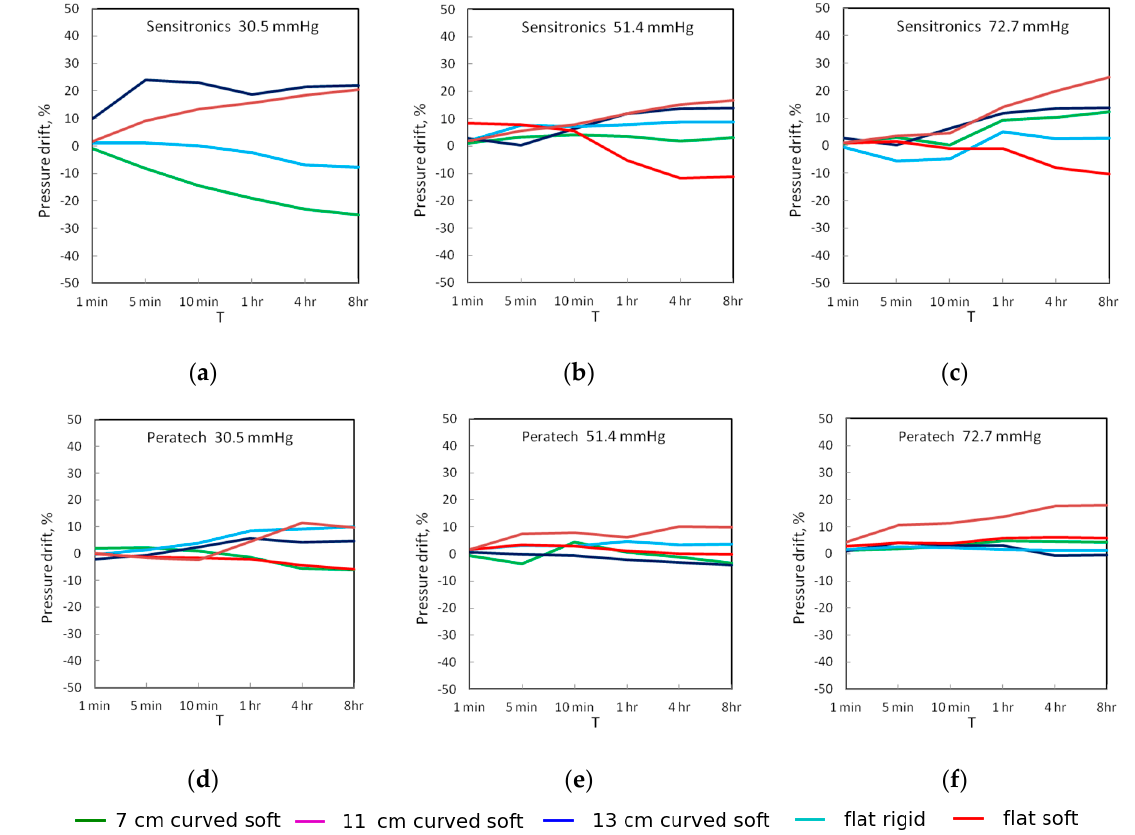
Figure 8. Static drift of measured pressure for sensors at the three applied pressures: ( a – c ) Sensitronics; ( d – f ) Peratech.